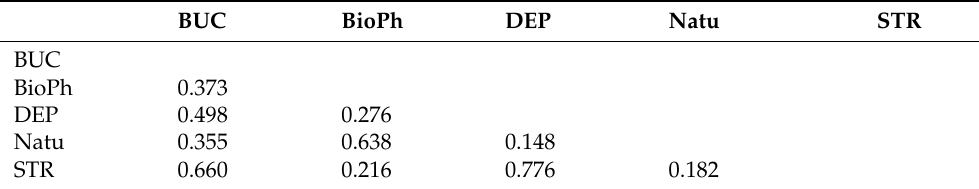
Table 4. Discriminant validity of modeling based on the Heterotrait–Monotrait ratio (HTMT).